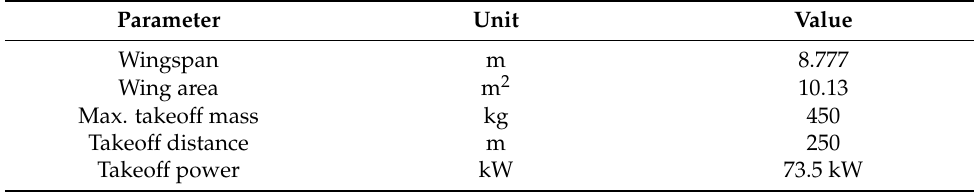
Table 1. Specification of the Promecc